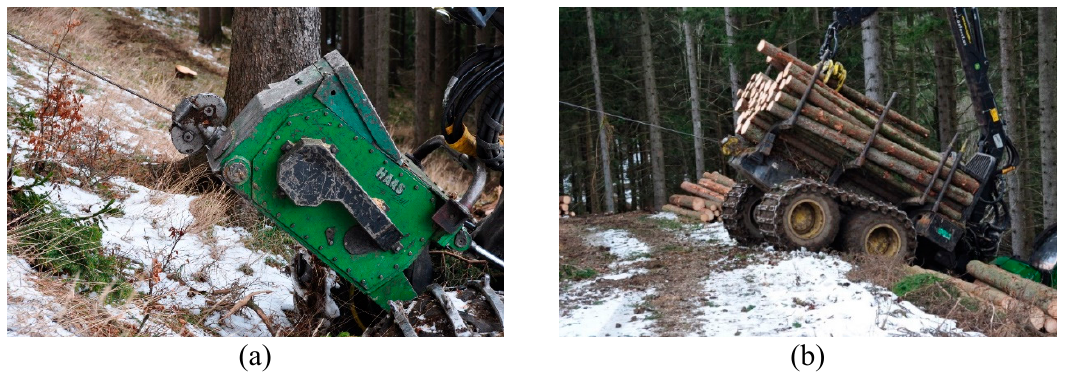
Figure 1. Observed John Deere 1170 E harvester with a mounted winch in the front ( a ) and a John Deere 1110 E forwarder with an integrated winch ( b ).